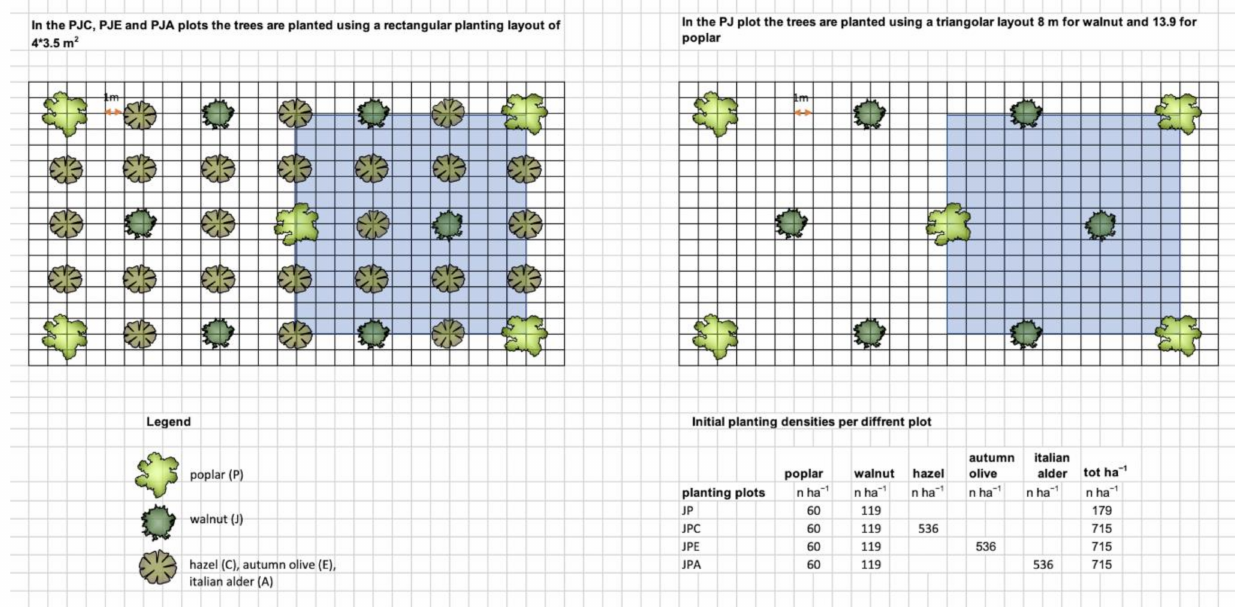
Figure 1. Planting layout of the different afforested plots (PJ, PJC, PJE, and PJA). 1. Poplar and walnut (plots PJ), planted in a high-density mixture. 2. Poplar and walnut intercropped with hazel ( Corylus avellana L., Betulaceae) (plots PJC), a native shrub frequent in the surrounding forests. 3. Poplar and walnut intercropped with autumn olive ( Elaeagnus umbellata Thunb., Elaeagnaceae) (plots PJE), an alien N-fixing shrub used in tree farming plantations for its high ability to fix nitrogen in the